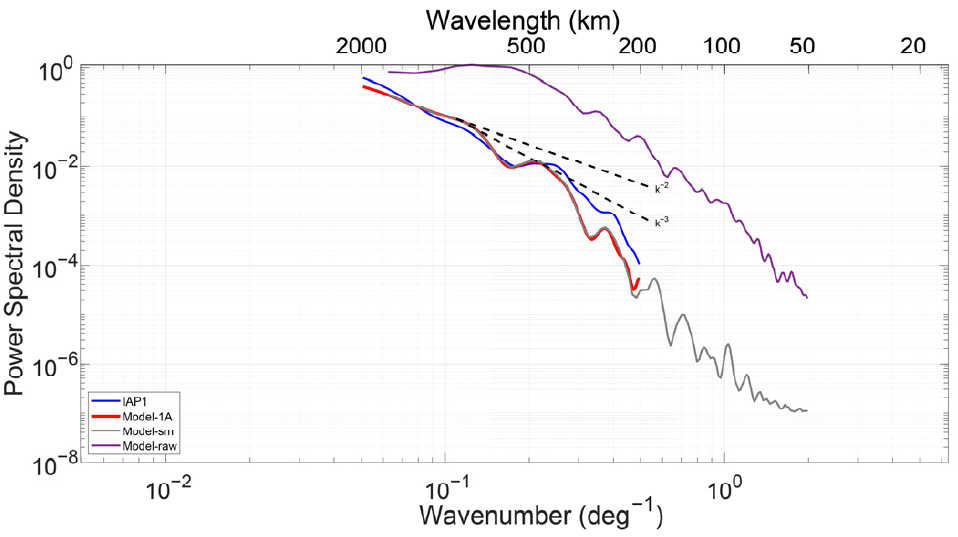
Figure 2. Wavenumber spectrum distributions in the Kuroshio and its extension region at 5 m depth.